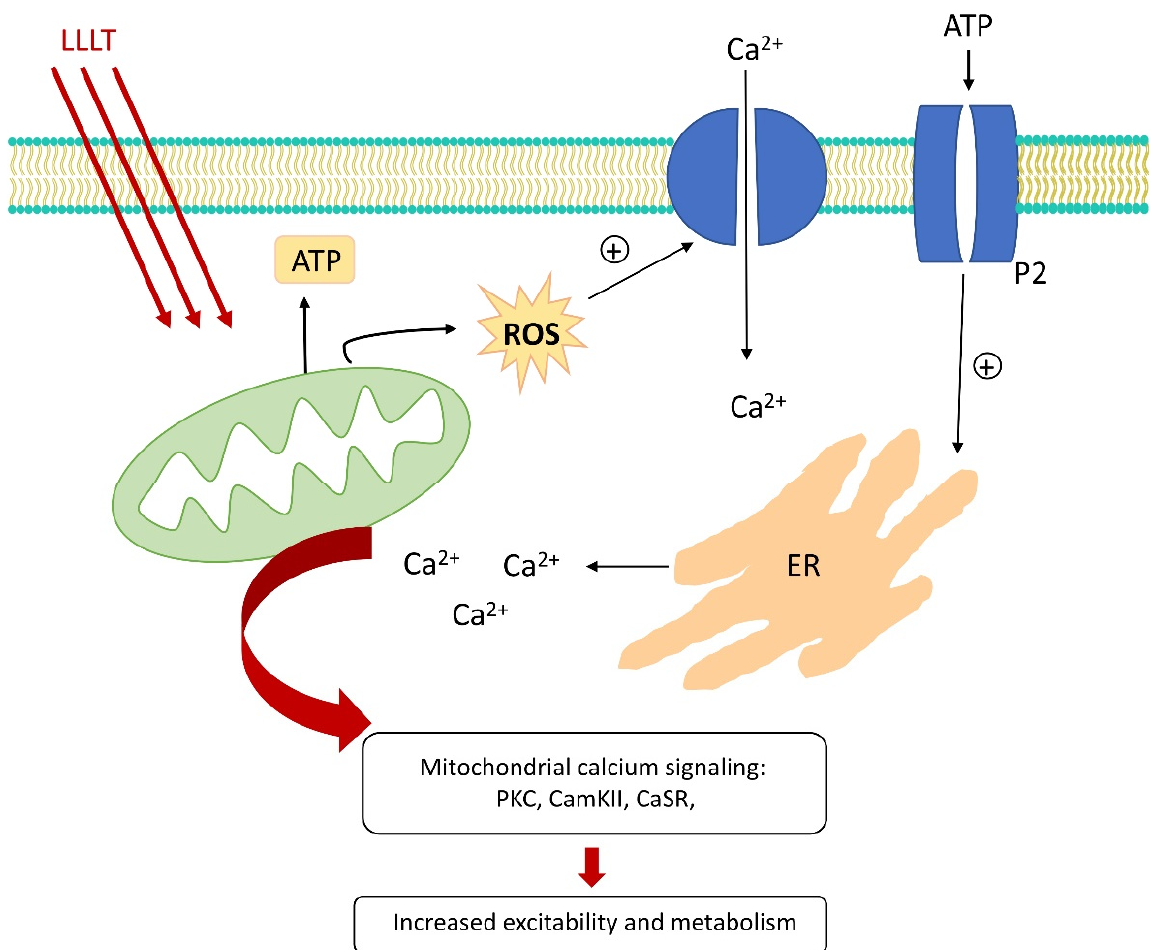
Figure 4. Changes in ion concentration after LLLT.